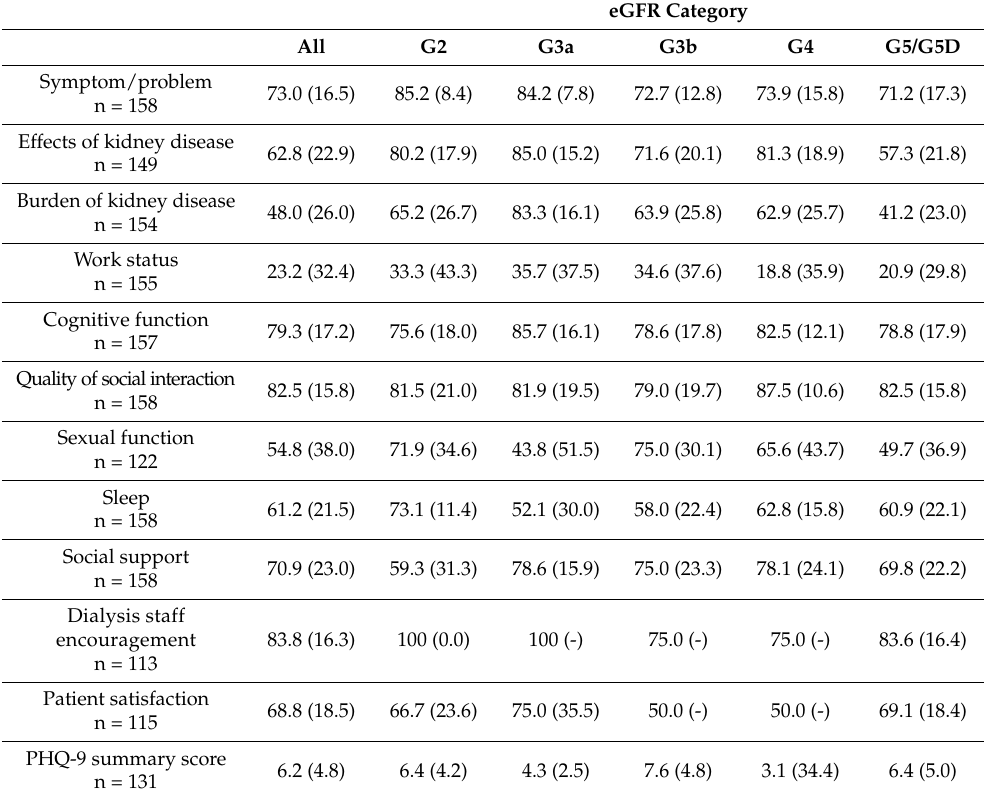
Table 4. Kidney disease targeted areas (KDQOL) and PHQ-9.